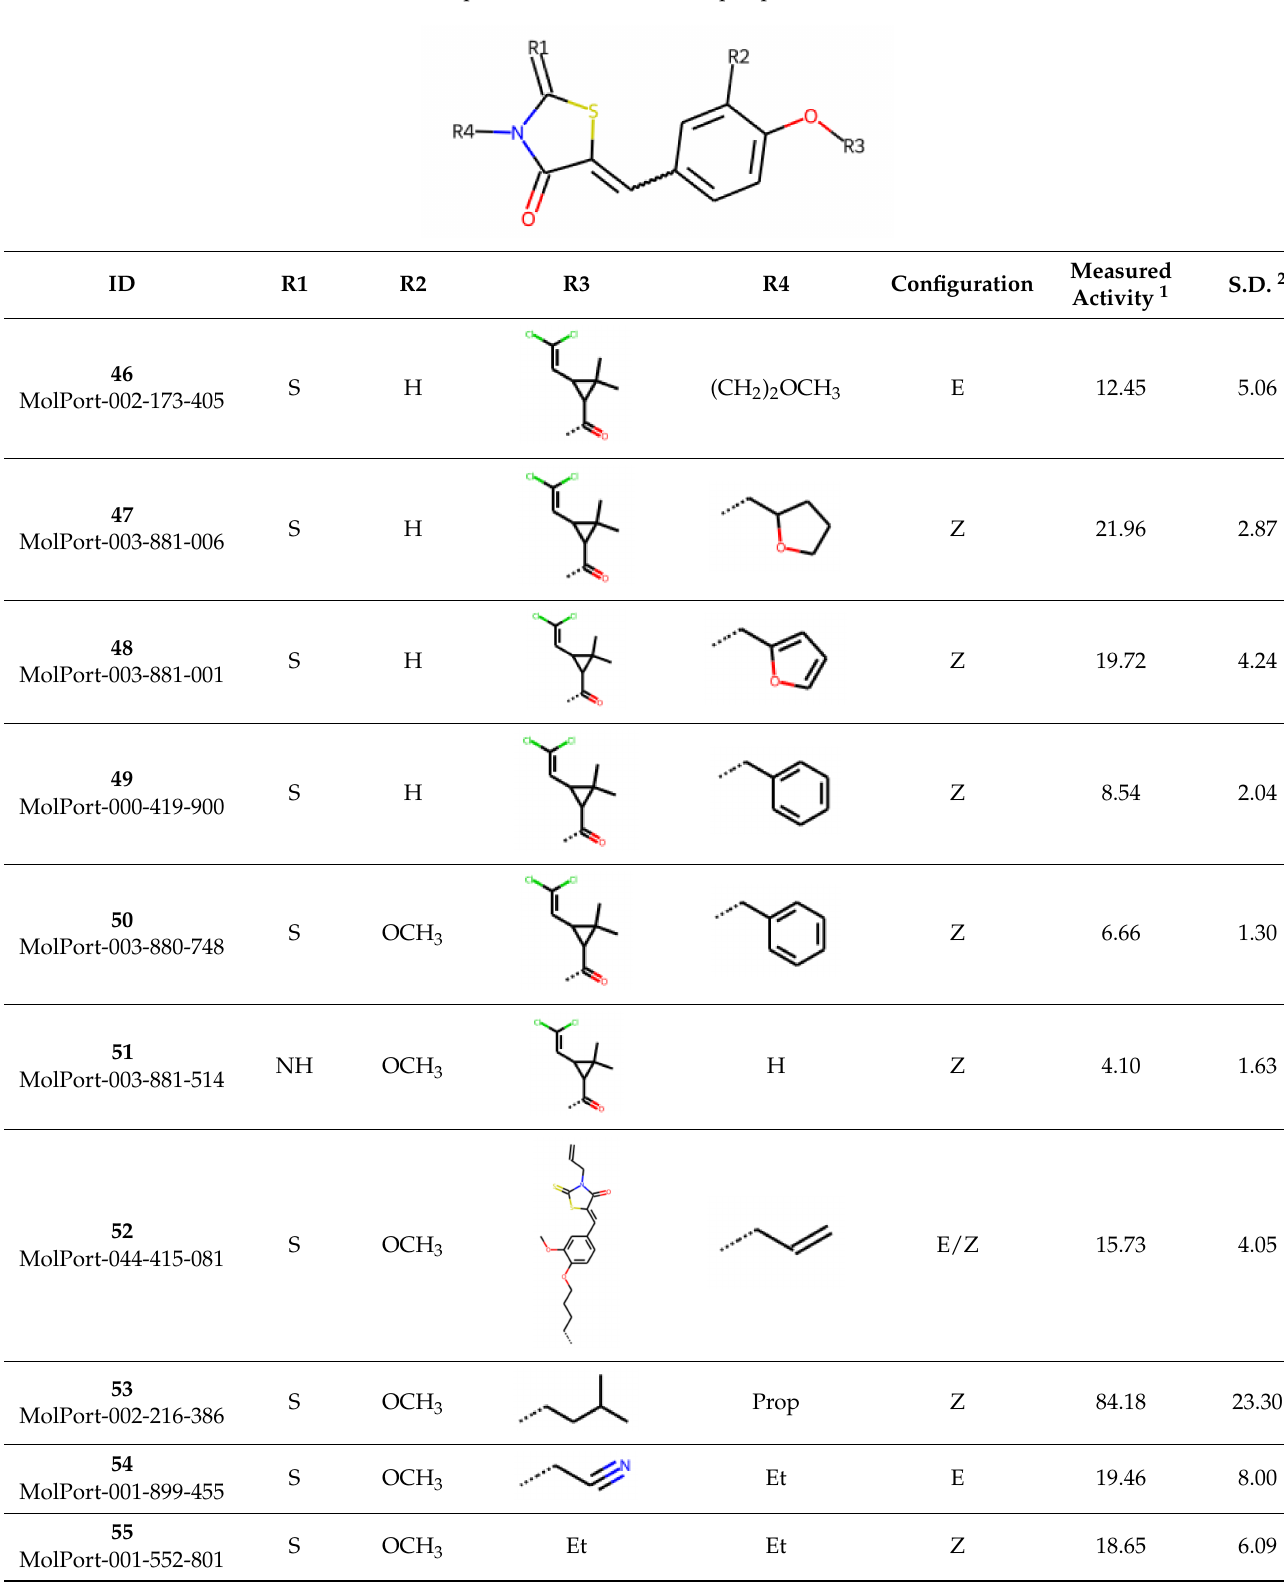
Table 7. Compounds tested in follow-up experiments related to 17